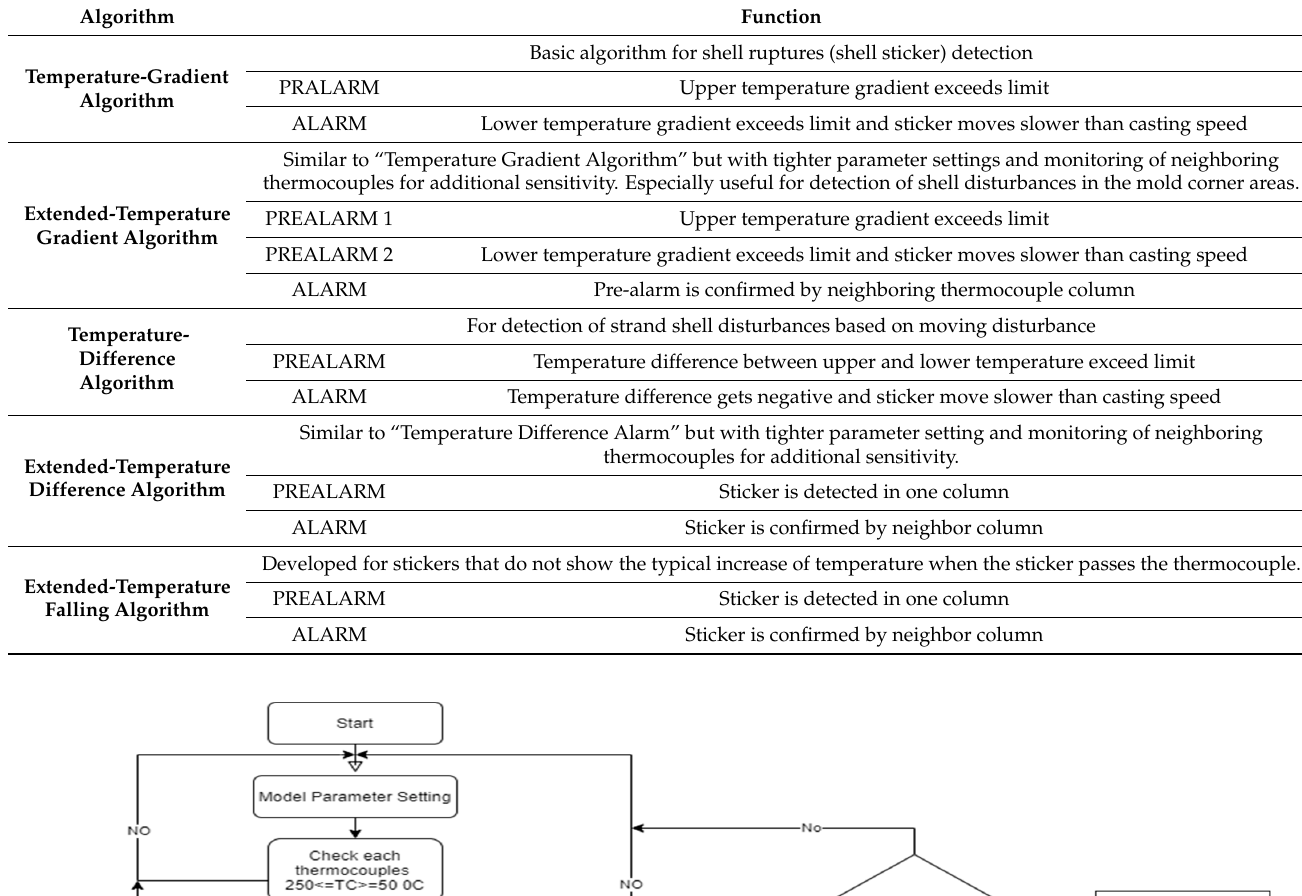
Table 3. Sticker detection algorithm details for new logic judgment model.